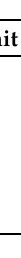
Figure 5. Wind generation power distribution over five days. Table 1. Available capacity of each of system components.